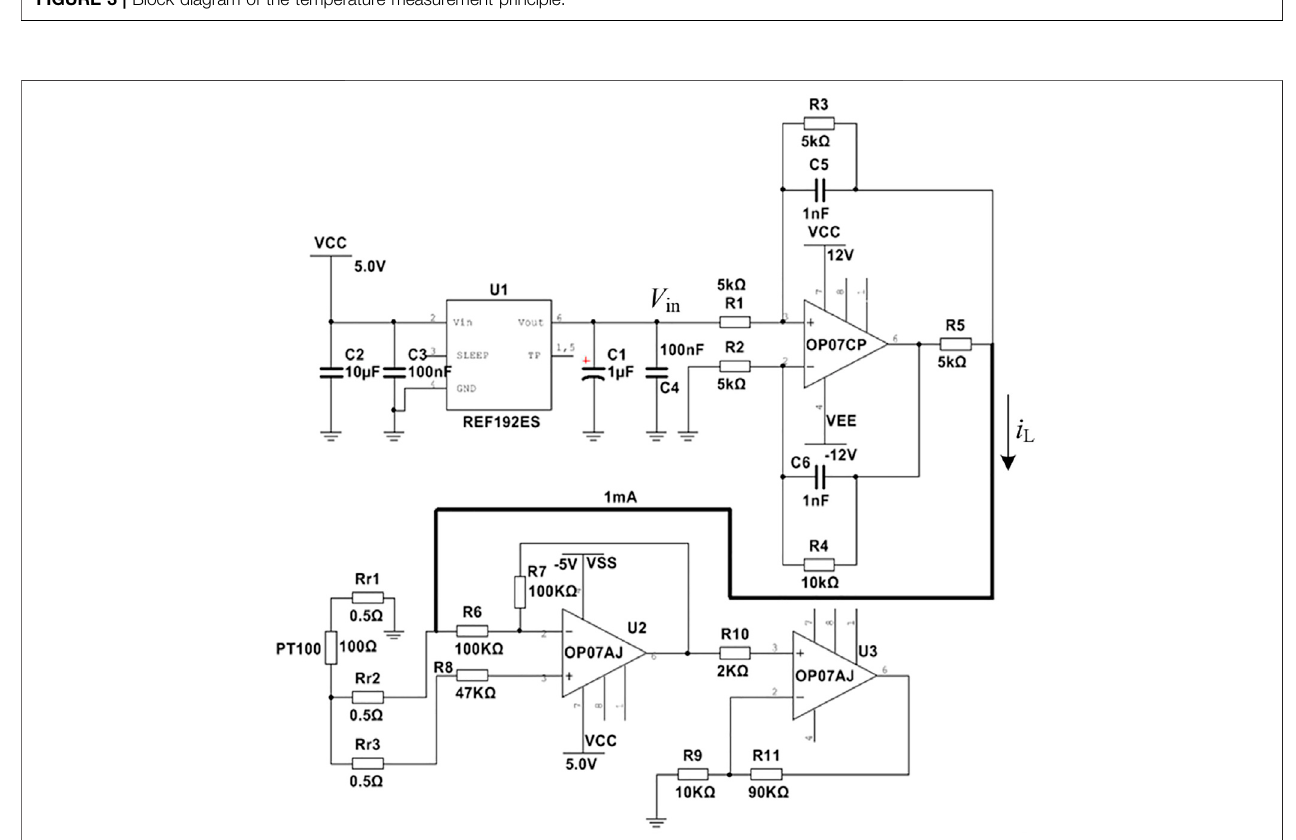
FIGURE 4 | The platinum resistance temperature measurement